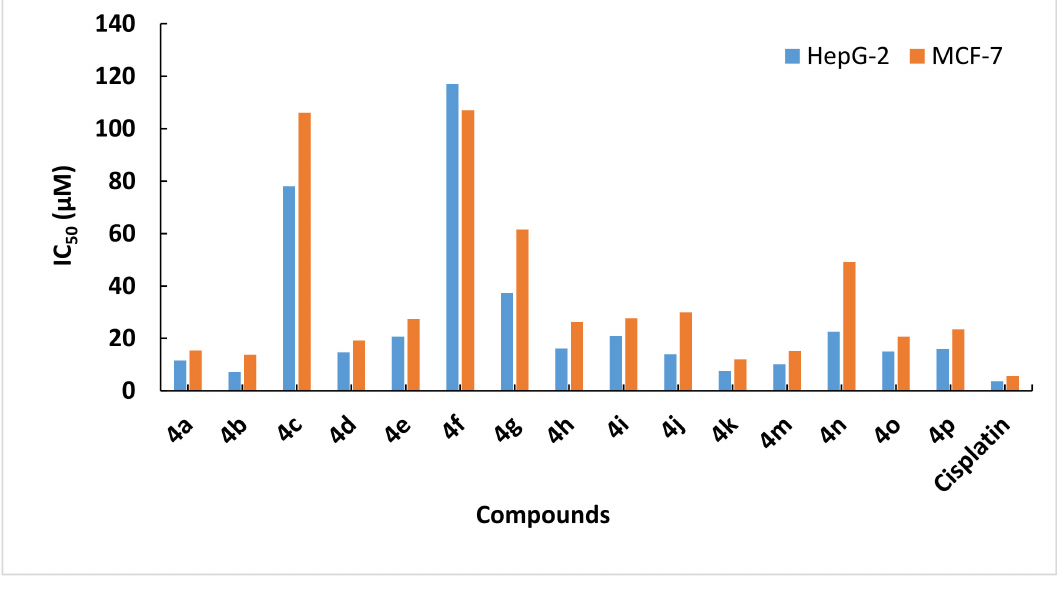
Figure 2. Cytotoxic activities of tested compounds against human hepatocellular carcinoma (HepG-2) and human breast cancer cell line MCF-7 cells. Table 1. The in vitro inhibitory activity expressed as 50% inhibitory concentration values ( µ g / mL) of tested compounds against HepG-2 and MCF-7 cancer cell